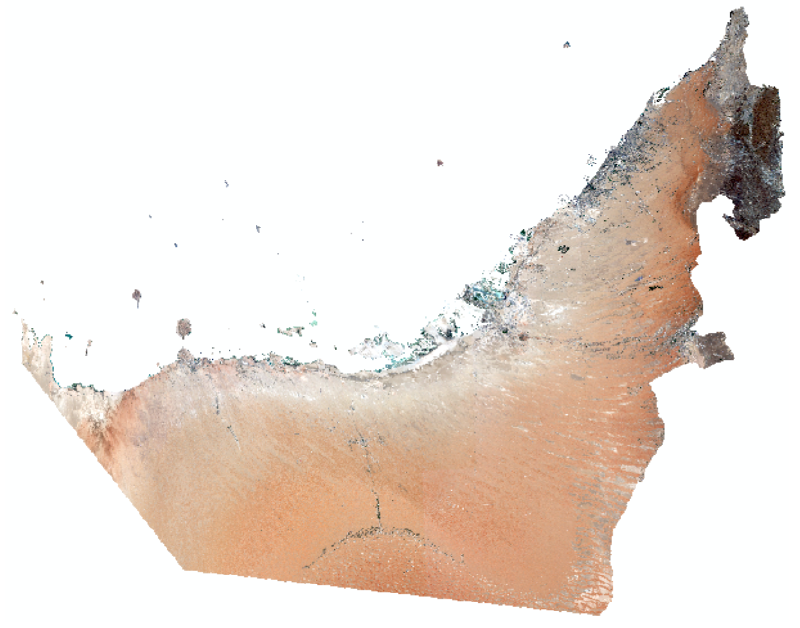
Figure 9. The mosaic of UAE developed using the proposed approach on Sentinel-2 Level 1C